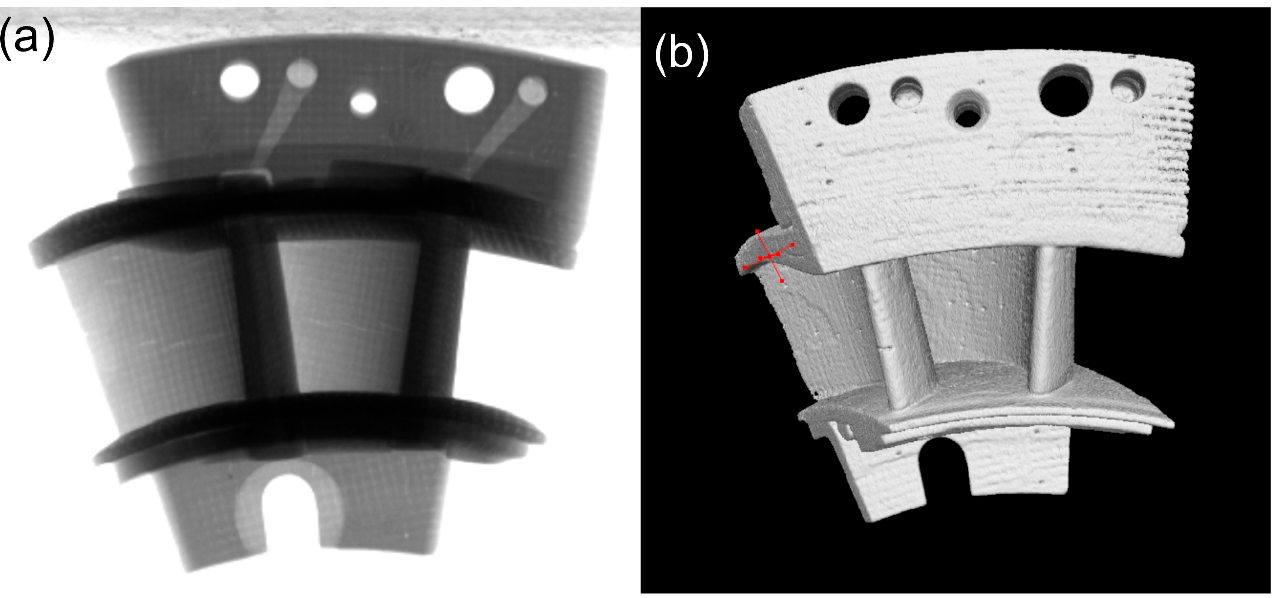
Figure 1. The photograph of SiC/SiC twin guide vanes observed under XCT ( a ) Front view; and ( b ) Back view.